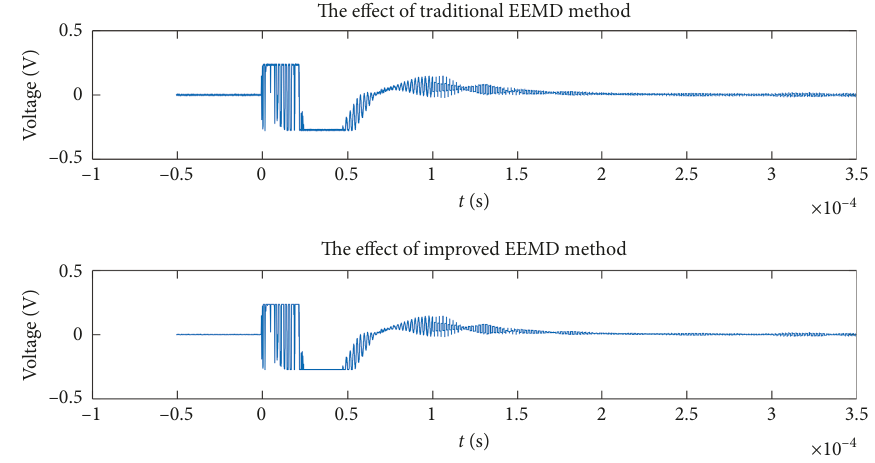
Figure 10: The comparison results of the two methods.